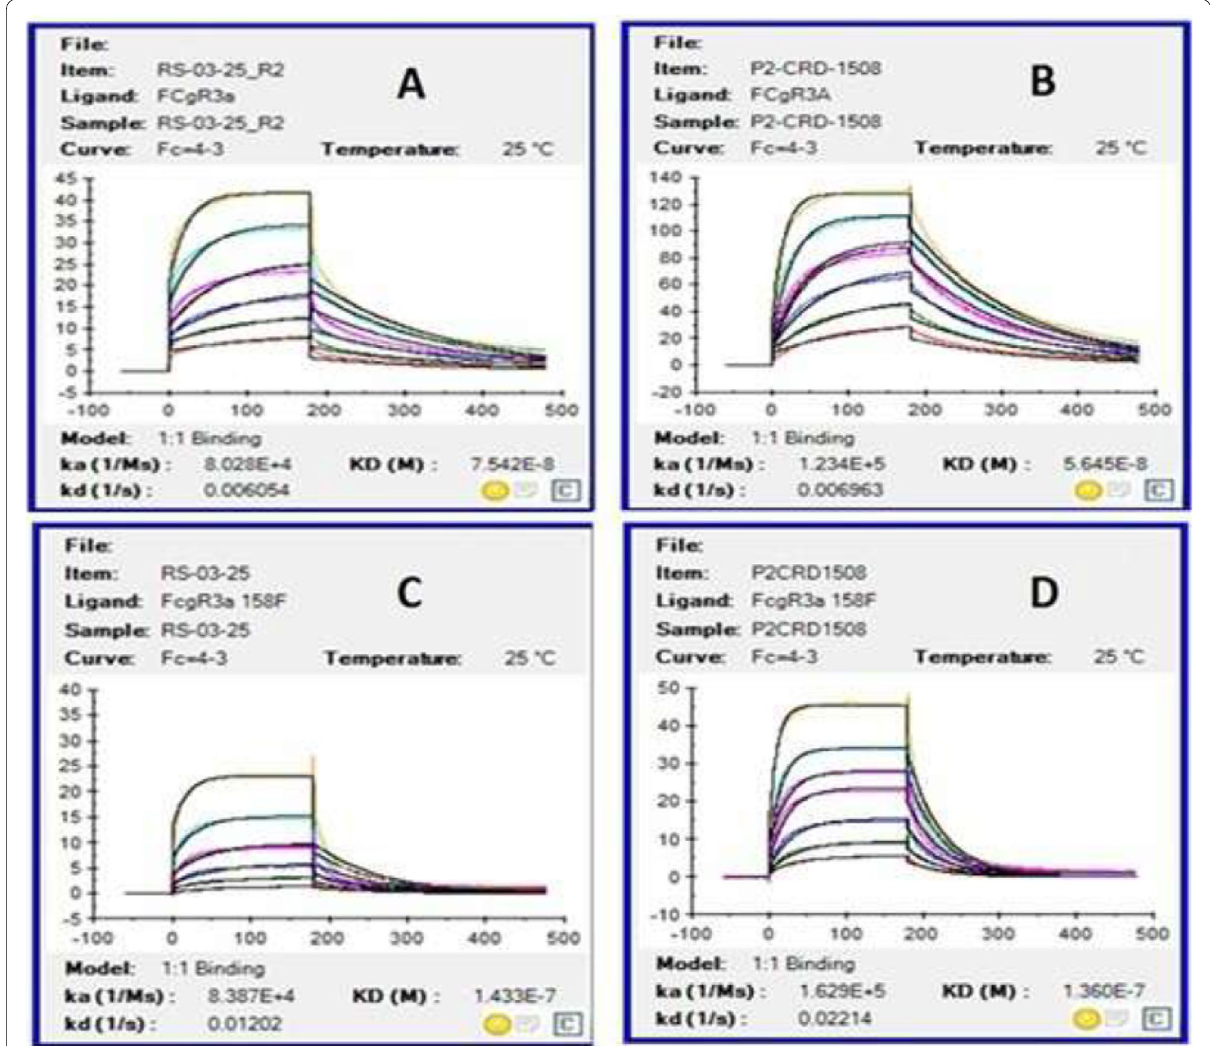
Fig. 4 SPR sensorgrams obtained for FcγRIIIa V158 ( A , B ) and F158 ( C , D ) receptors for the test anti-CD20 antibody (P2-CRD-1508) ( B , D ) and control antibody (RS-03-25) ( A , C ). It can be seen from the figure that the association ( k a ), dissociation ( k d ), and binding affinity (KD) of test antibody (P2-CRD-1508) was high in comparison to control antibody (RS-03-25)